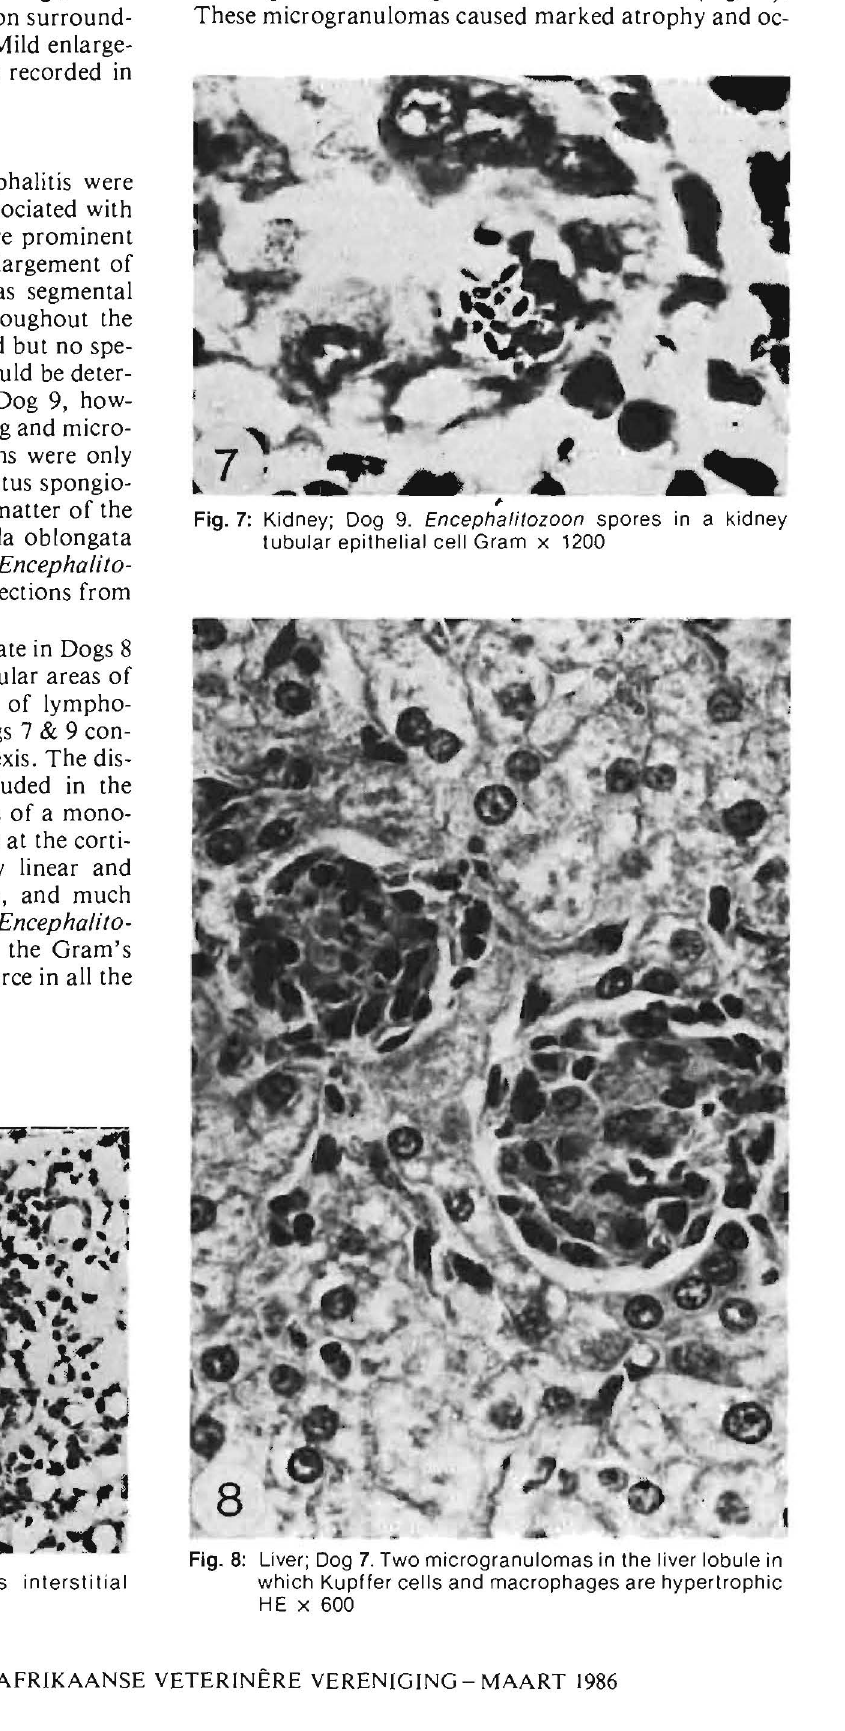
Fig. 8: Liver; Dog 7. Two microgranulomas in the liver lobule in which Kupffer cells and macrophages are hypertrophic HE x